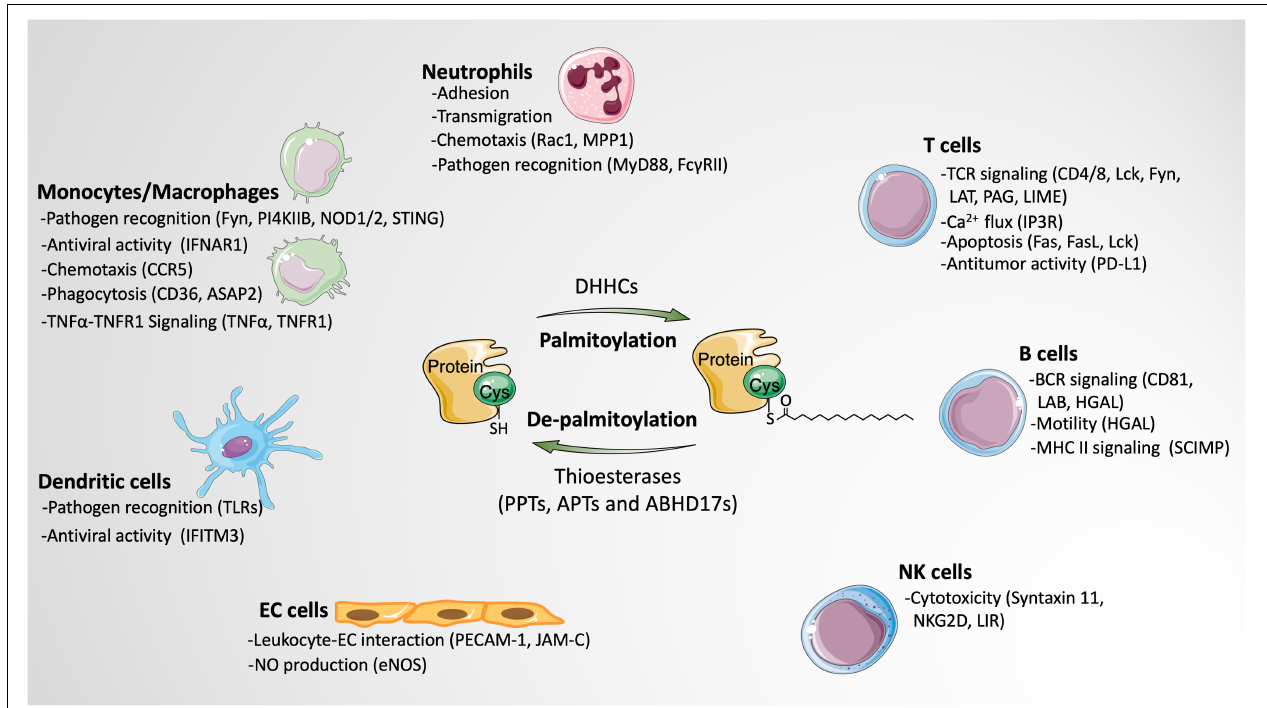
FIGURE 2 | The impact of protein palmitoylation on leukocyte signaling and function. Protein palmitoylation modulates various functions of leukocytes by altering the activities of palmitoylated proteins in different subtypes of leukocytes. Besides, palmitoylation also indirectly affects leukocyte behaviors through regulating the function of endothelial cells. Palmitoylated proteins involved in the particular function are listed in parentheses. Images of cells and proteins were obtained from Smart Servier Medical Art